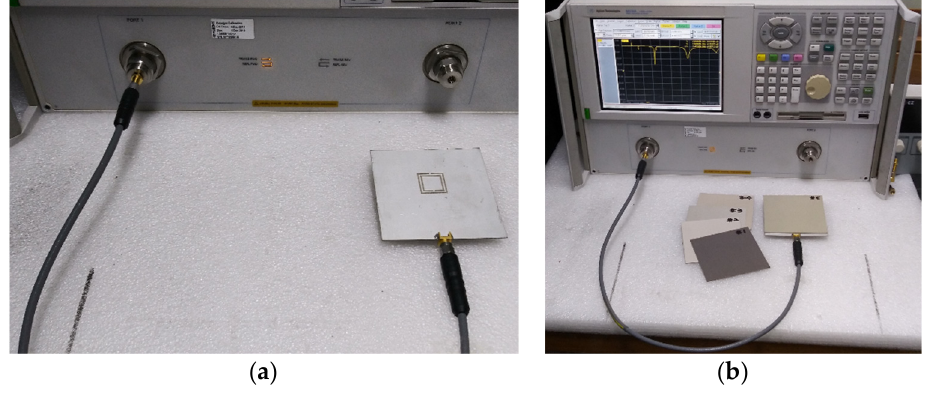
Figure 11. Experiment setups: ( a ) unloaded; ( b ) loaded.